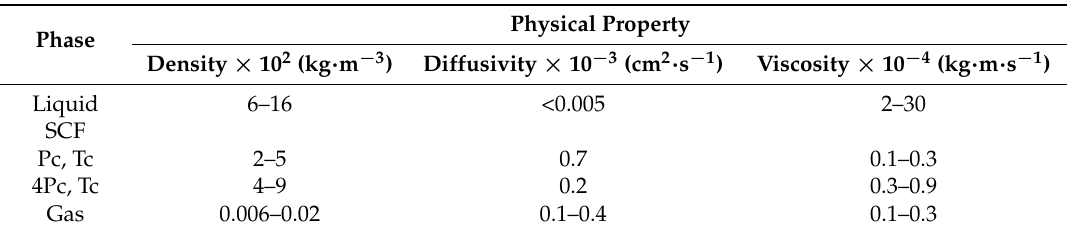
Table 2. The relative properties of liquid, gas and SCF